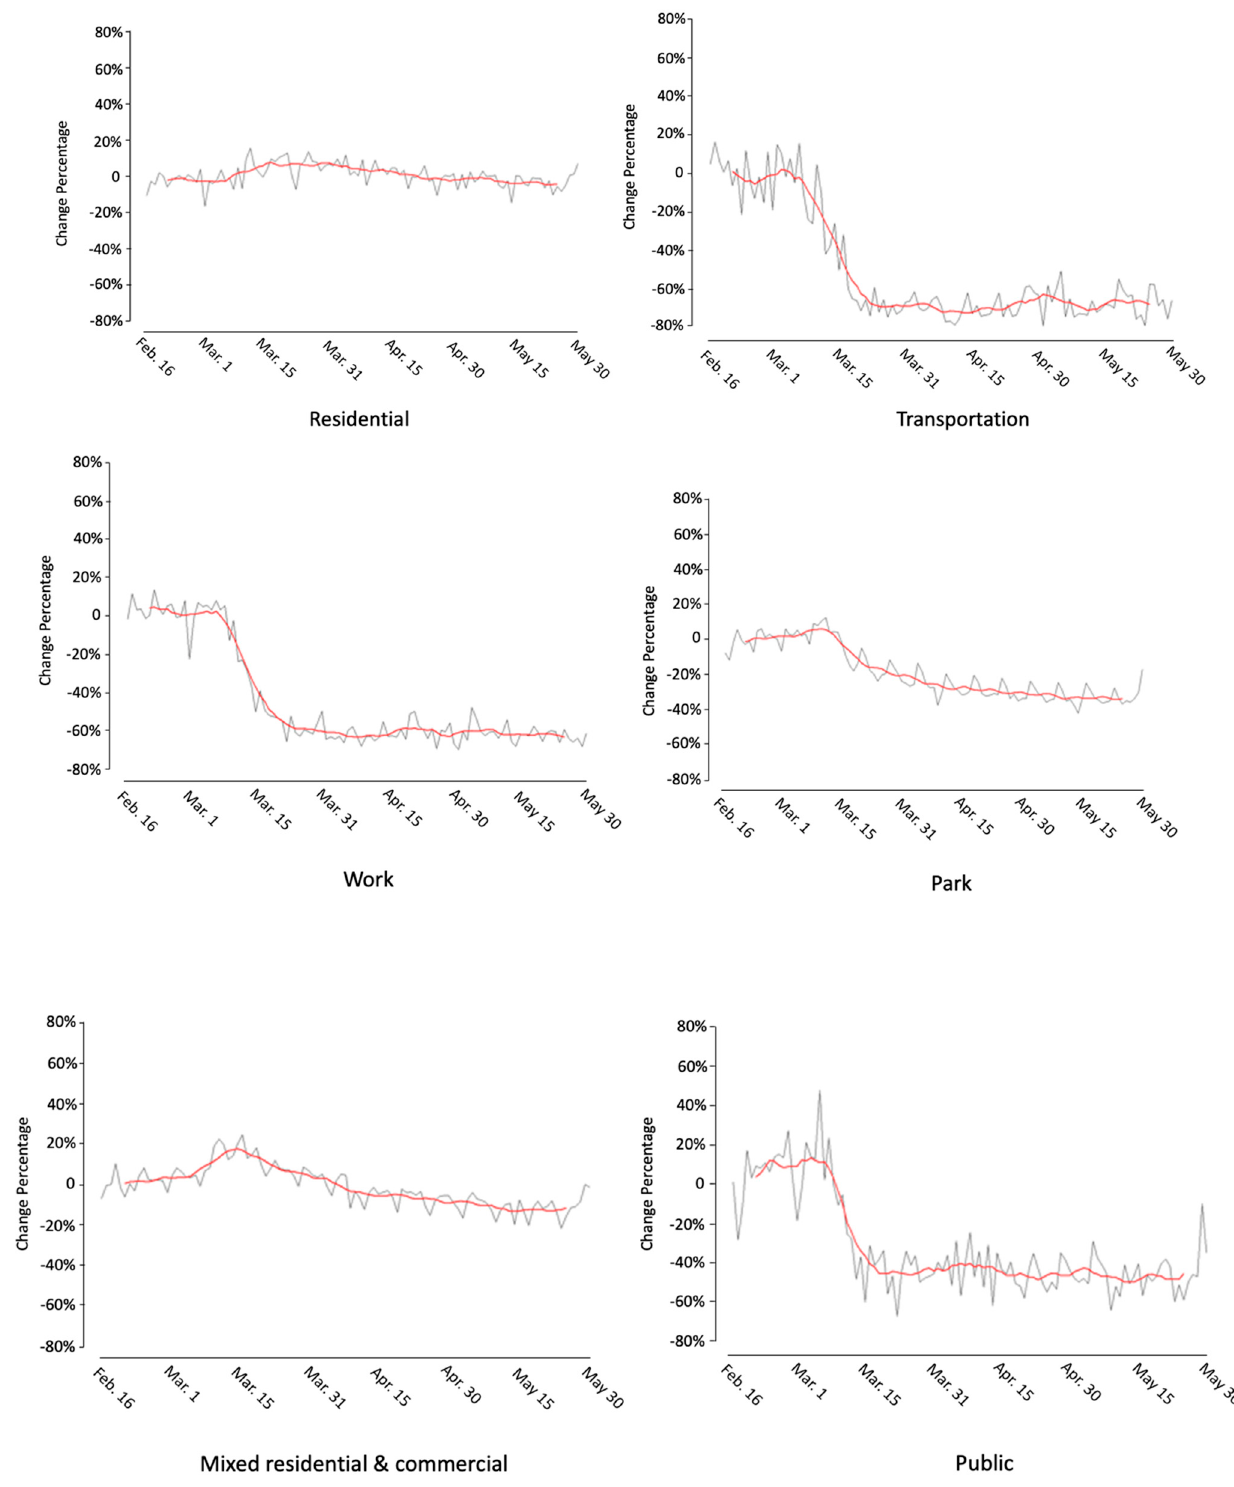
Figure 3. Mobility changing patterns for six land use types based on Twitter